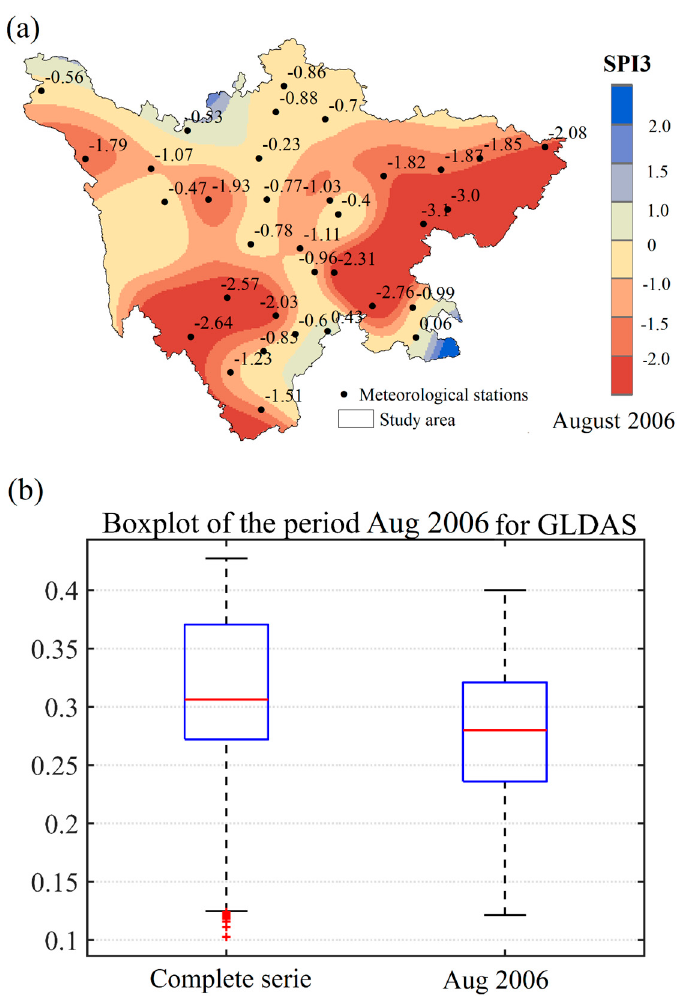
Figure 7. August 2006 drought event as seen by SPI and GLDAS ( a ) for SPI in August 2006 and ( b ) for the boxplot of the period of August 2006 for GLDAS (upper and lower whiskers, 95th and 5th percentile value; upper and lower borders of the box, the upper quartile and lower quartile; red line, medium value).